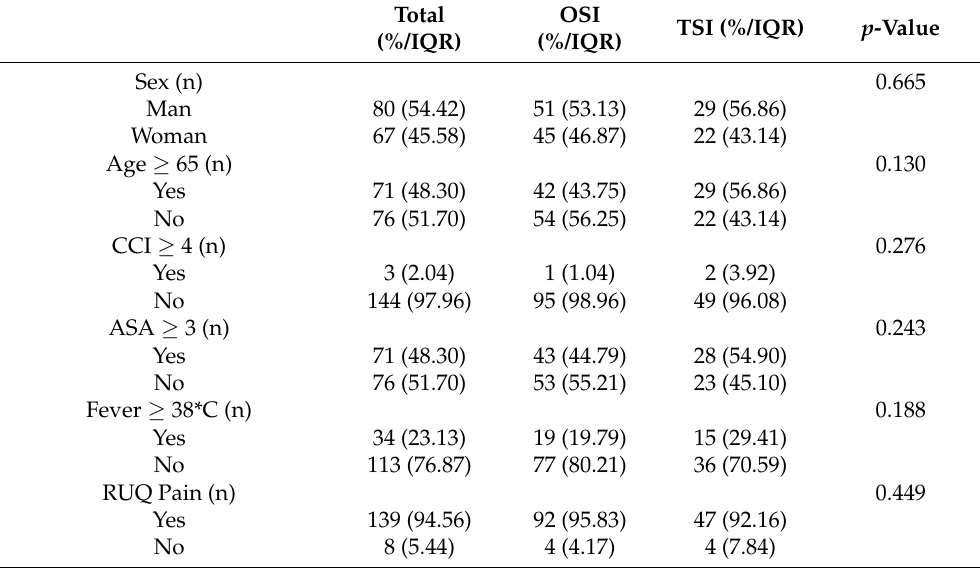
Figure 2. Inclusion and exclusion criteria for the patients diagnosed with concurrent acute chole- cystitis and acute cholangitis and later underwent intended laparoscopic cholecystectomy. ERCP, endoscopic retrograde cholangiopancreatography; LC, laparoscopic cholecystectomy; OP, operation; cACC, concurrent acute cholecystitis and cholangitis. Table 1. The analysis of demographic data and recurrent biliary events (RBE) between one-stage intervention (OSI) group and two-stage intervention (TSI)